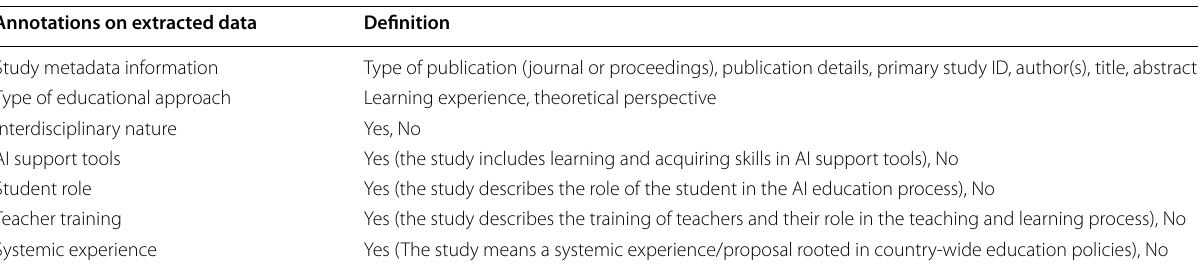
Table 2 Data extraction annotations definitions Annotations on extracted